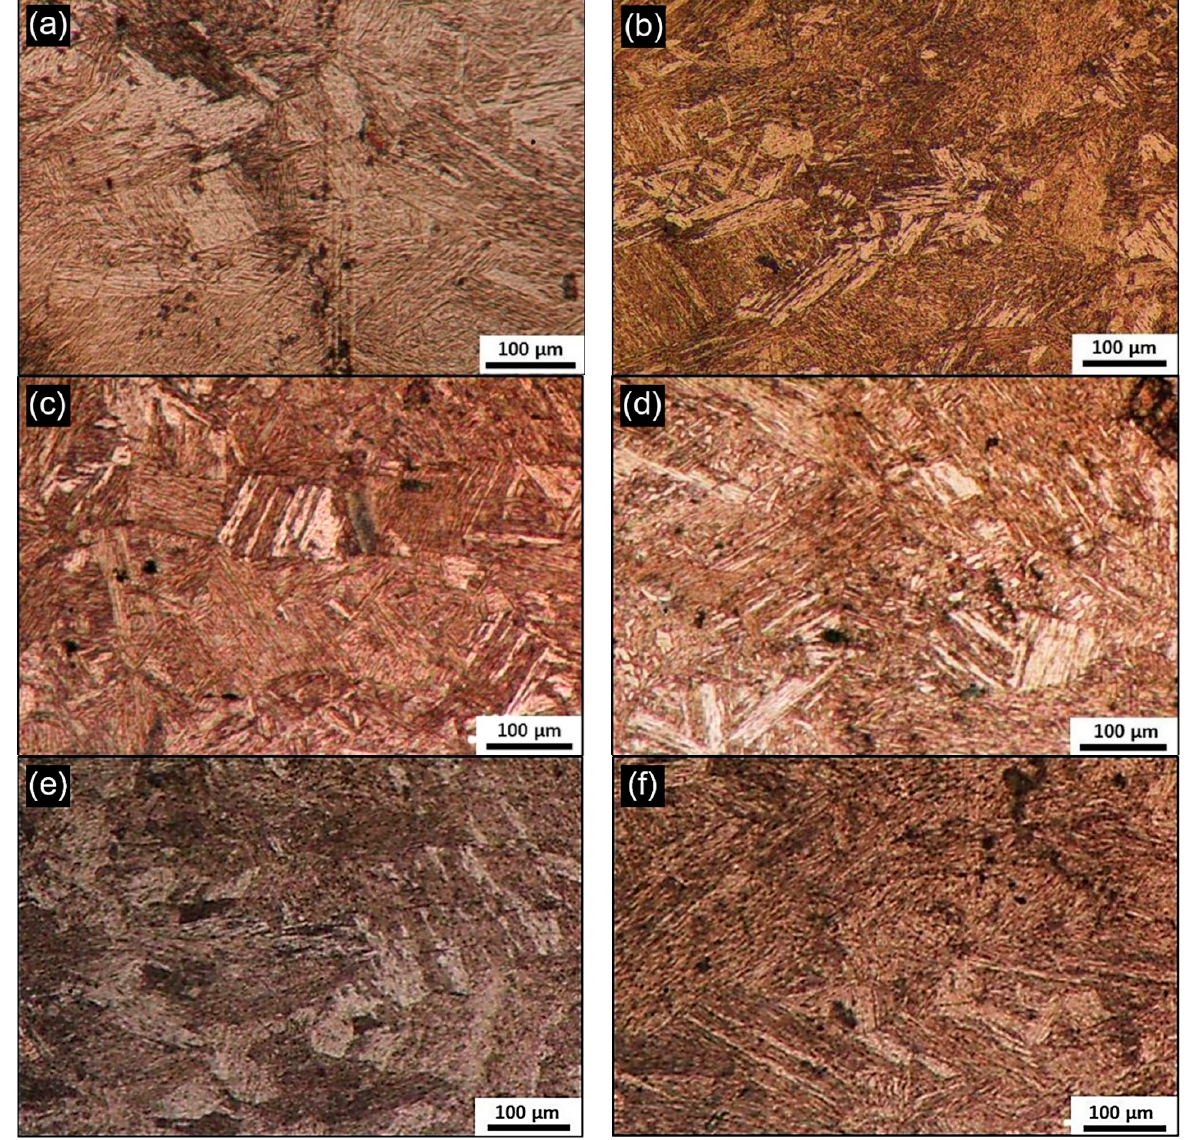
Figure 4. Effect of heat input on fusion zone microstructure, ( a ) 1.764 kJ/mm, ( b ) 1.995 kJ/mm, ( c ) 2.035 kJ/mm, ( d ) 2.132 kJ/mm, ( e ) 2.229 kJ/mm, ( f ) 2.33 kJ/mm.